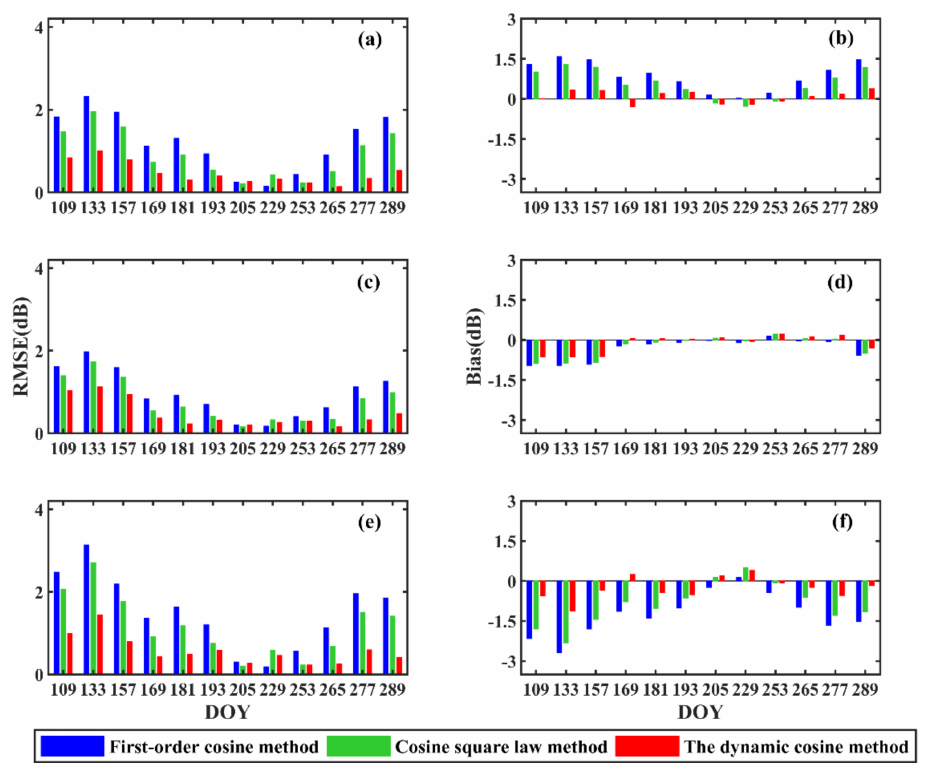
Figure 11. The same as Figure 10 but for VH